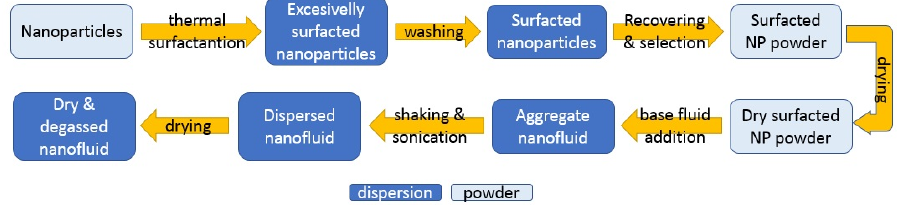
Figure 14. Preparation method for dielectric nanofluids with improved stability.